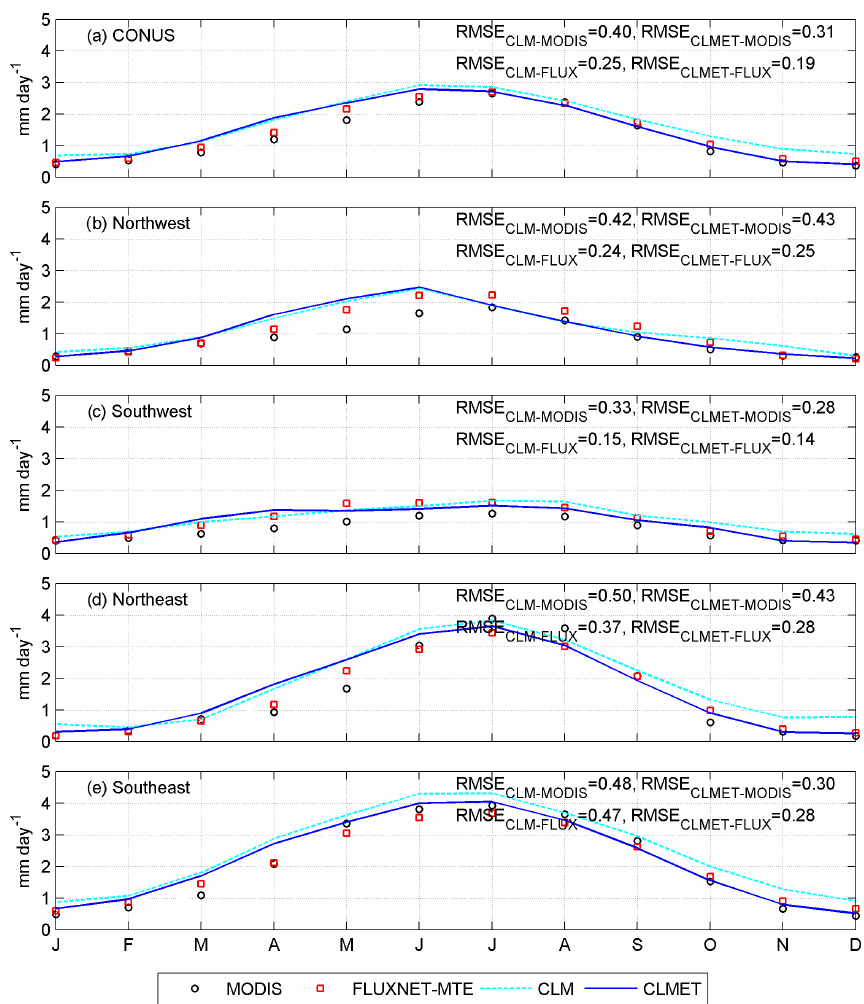
Figure 6. Seasonal cycles of ET from MODIS, FLUXNET-MTE, the CLM, and CLMET over (a) the CONUS, (b) Northwest, (c) Southwest, (d) Northeast, and (e) Southeast during the period 2000–2011. Table 4. Statistics of simulated annual runoff coefficients (ratio of runoff to total precipitation) against GSCD observations over the CONUS, Northwest (NW), Southwest (SW), Northeast (NW), and Southeast (SW) during the period 2000–2014. Bias Relative bias